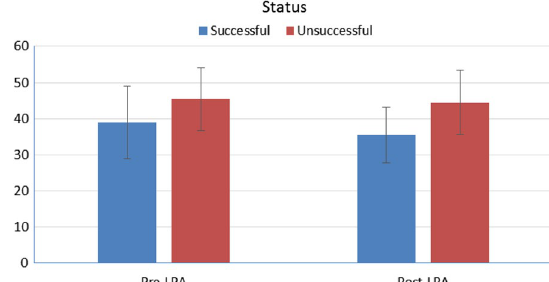
Fig. 3 Bar graph demonstrating level III negative and positive percentages before and after surgical interference